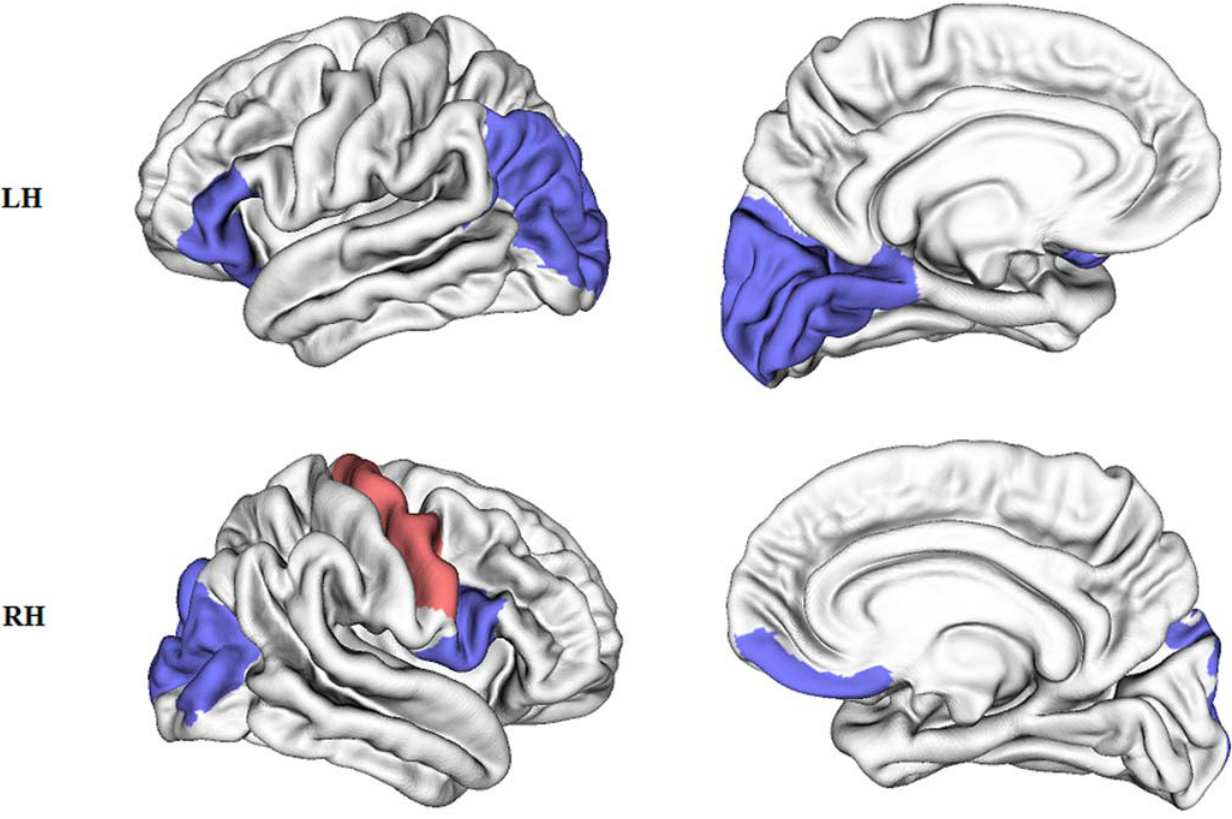
Figure 3. Cortical regions with altered topological properties in early blind subjects ( p , 0.05). Blue: regions with decreased K i and E i_glob and increased L i in the early blind; Red: regions with increased K i and E i_glob in the early blind; Top: left hemisphere (LH); Bottom: right hemisphere (RH).